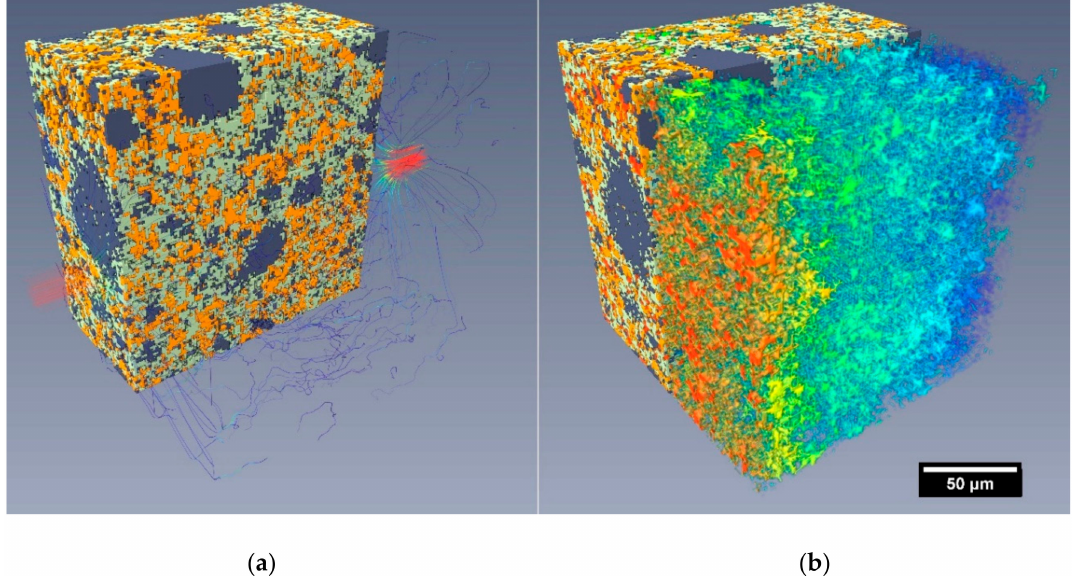
Figure 10. Volume rendering of the microstructure of VCCTL specimen V 1 7 days overlaid with ( a ) simulated flow visualisation in the X-direction (red to blue colours indicating high to low relative velocity). ( b ) The corresponding pressure field, with colour indicating the relative pressure (red high pressure, 1.51 MPa, to blue low pressure, 0.01